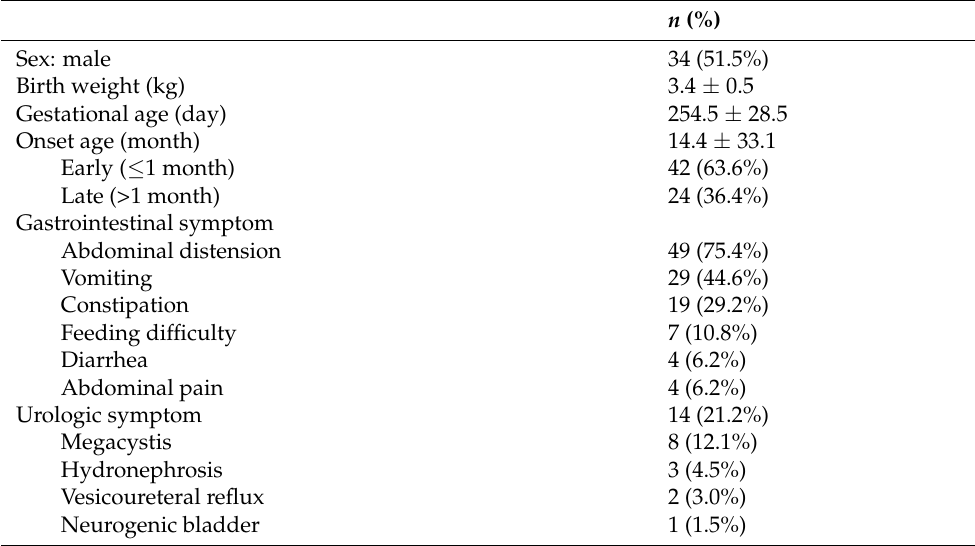
Table 1. General characteristics of pediatric chronic intestinal pseudo-obstruction